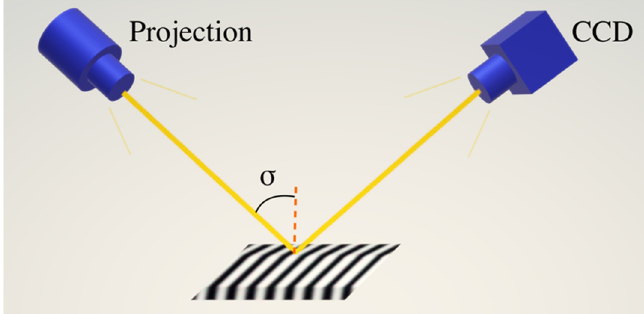
Figure 1. Optical path diagram of surface measured by a structured light measuring system.